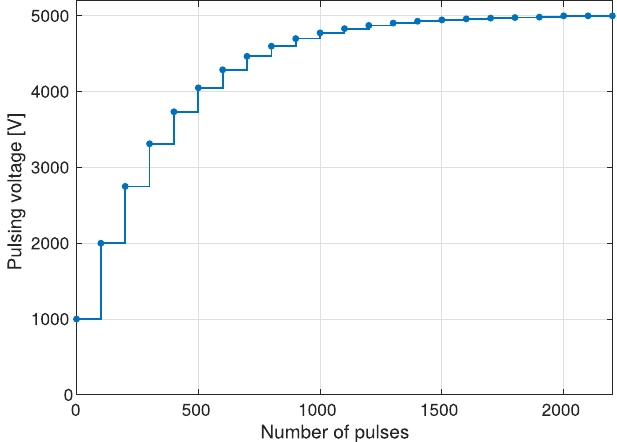
FIG. 4. Asymptotic ramping period after a BD at V ¼ 5000 V (which is E ¼ 83 MV = m, based on E ¼ V=d ). Each dot repre- sents the start of a new ramping step of 100 pulses. The ramping starts from one fifth of the target voltage. A BD may also occur at any time during the ramping, after which the ramping starts over again, though the target voltage stays the same as before.